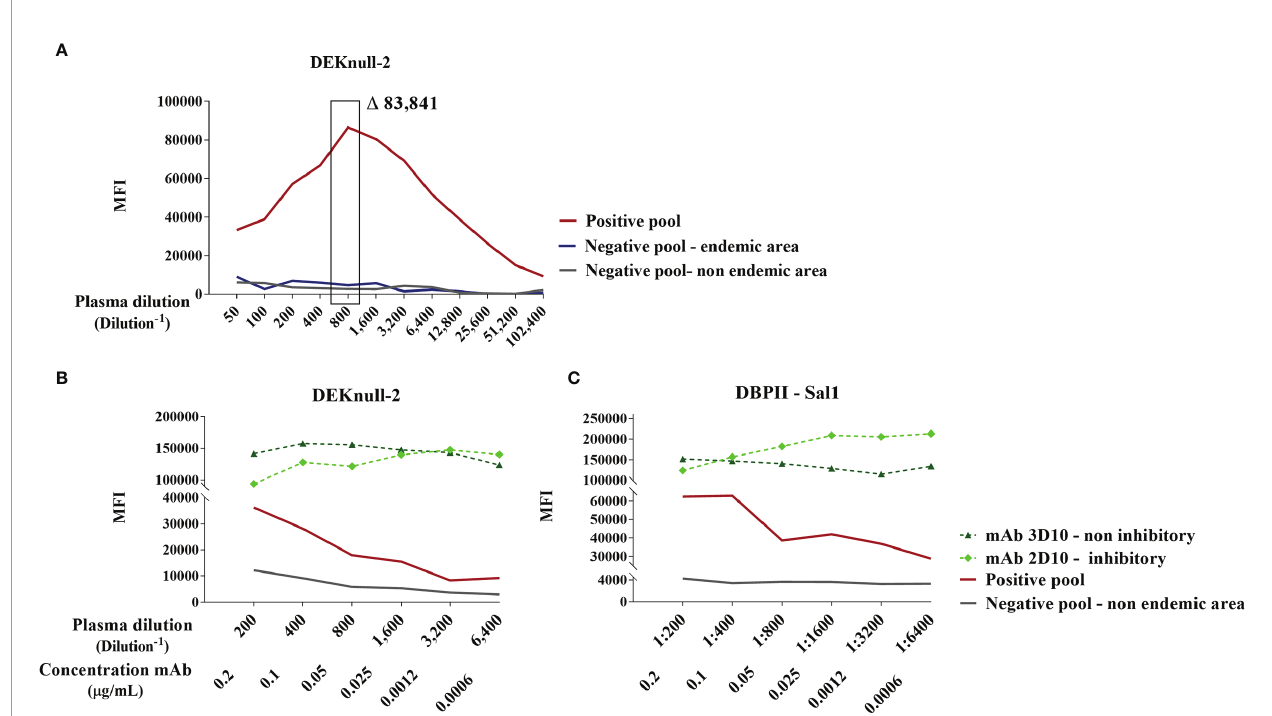
FIGURE 1 | Standardization of DBPII-multiplexed microsphere-based cytometric assay. (A) Titration curve for anti-DEKnull-2 antibodies in plasma samples (1:50 – 102,400) from DBPII-negative pool from individuals living in a nonendemic area of malaria (gray), DBPII-negative pool from an endemic area (blue), and DBPII-positive pool obtained from malaria-exposed individuals who have BIAb response as determined by the reference method of the COS-7 cells (red). The highlighted rectangle represents the selected plasma dilution (1:800). The delta value ( D ) corresponds to the difference in the mean fl uorescence intensity (MFI) between the positive pool from malaria-exposed individuals and the pool from nonexposed individuals. (B, C) Titration curve of MFI to monoclonal antibodies (mAbs; 0.2 – 0.006 m g/ml) or plasma-pooled samples (1:200 – 6,400). Inhibitory mAb 2D10 was represented by a light-green diamond and noninhibitory mAb 3D10 by a dark green triangle. Plasma pooled from individuals living in a nonendemic area are represented with a gray line and positive pooled samples with a red line. The MFI values were obtained using the FlowJo program (version 10.4.1) according to the analysis strategy described in Figure S1